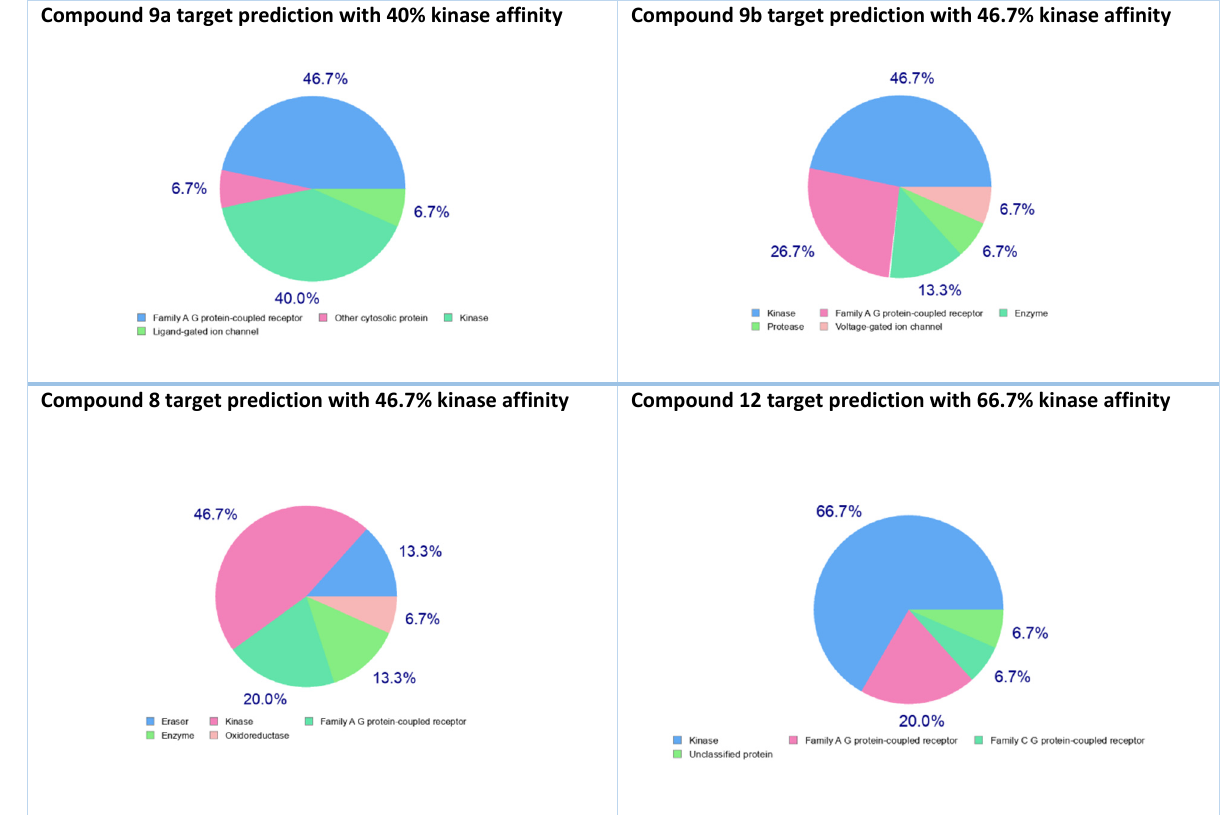
Figure 4. Compounds 9a , 9b, 8 , and 12 with the highest predicted kinase affinity of 40%, 46.7%, 46.7% and 66.7%